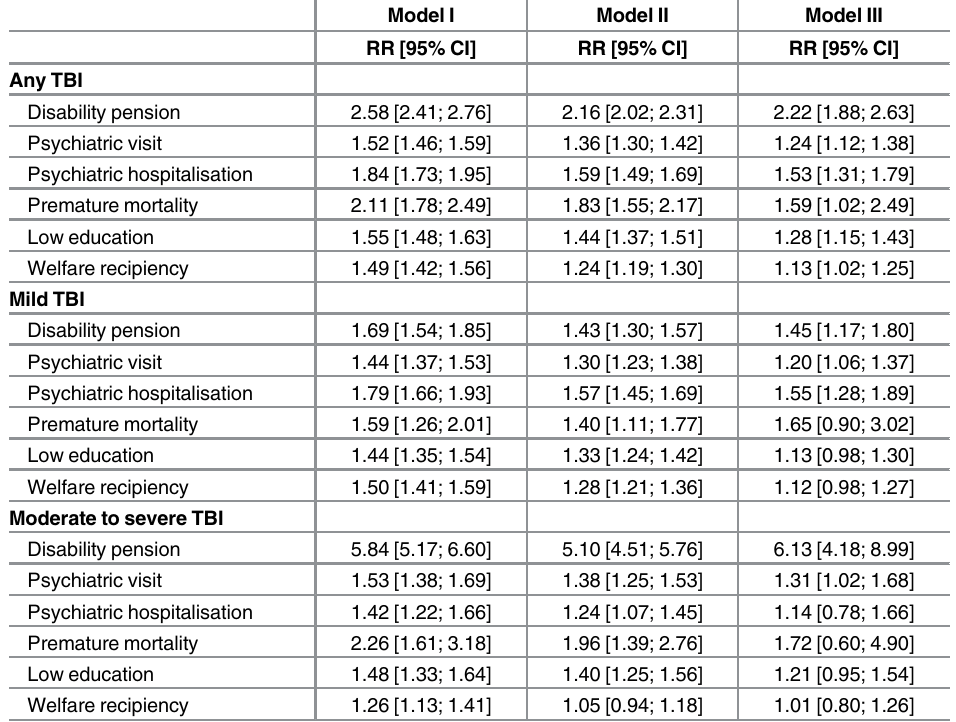
Table 6. Relative risks (RR) and corresponding 95% confidence intervals (CIs) for the associations between recurrent TBI compared to single-episode TBI, across injury severity, before age 25 y and poor functioning in